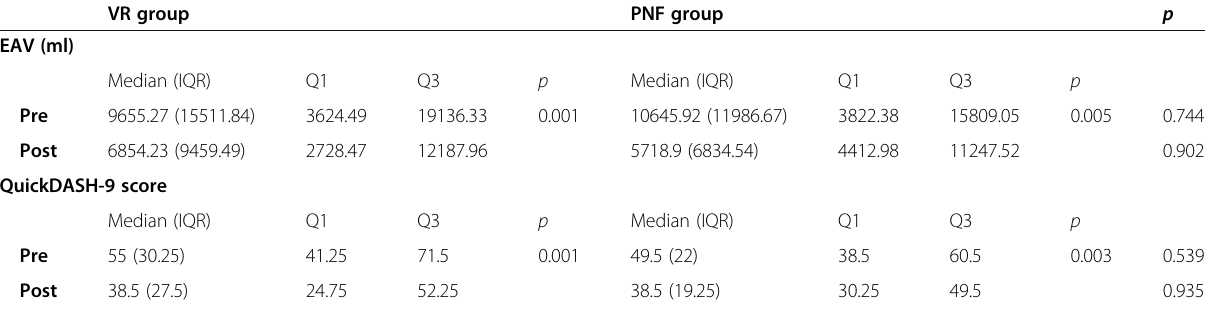
Table 2 Comparison between the pre- and post-treatment median [IQR] values of all the measured variables within each group and between the two groups VR group